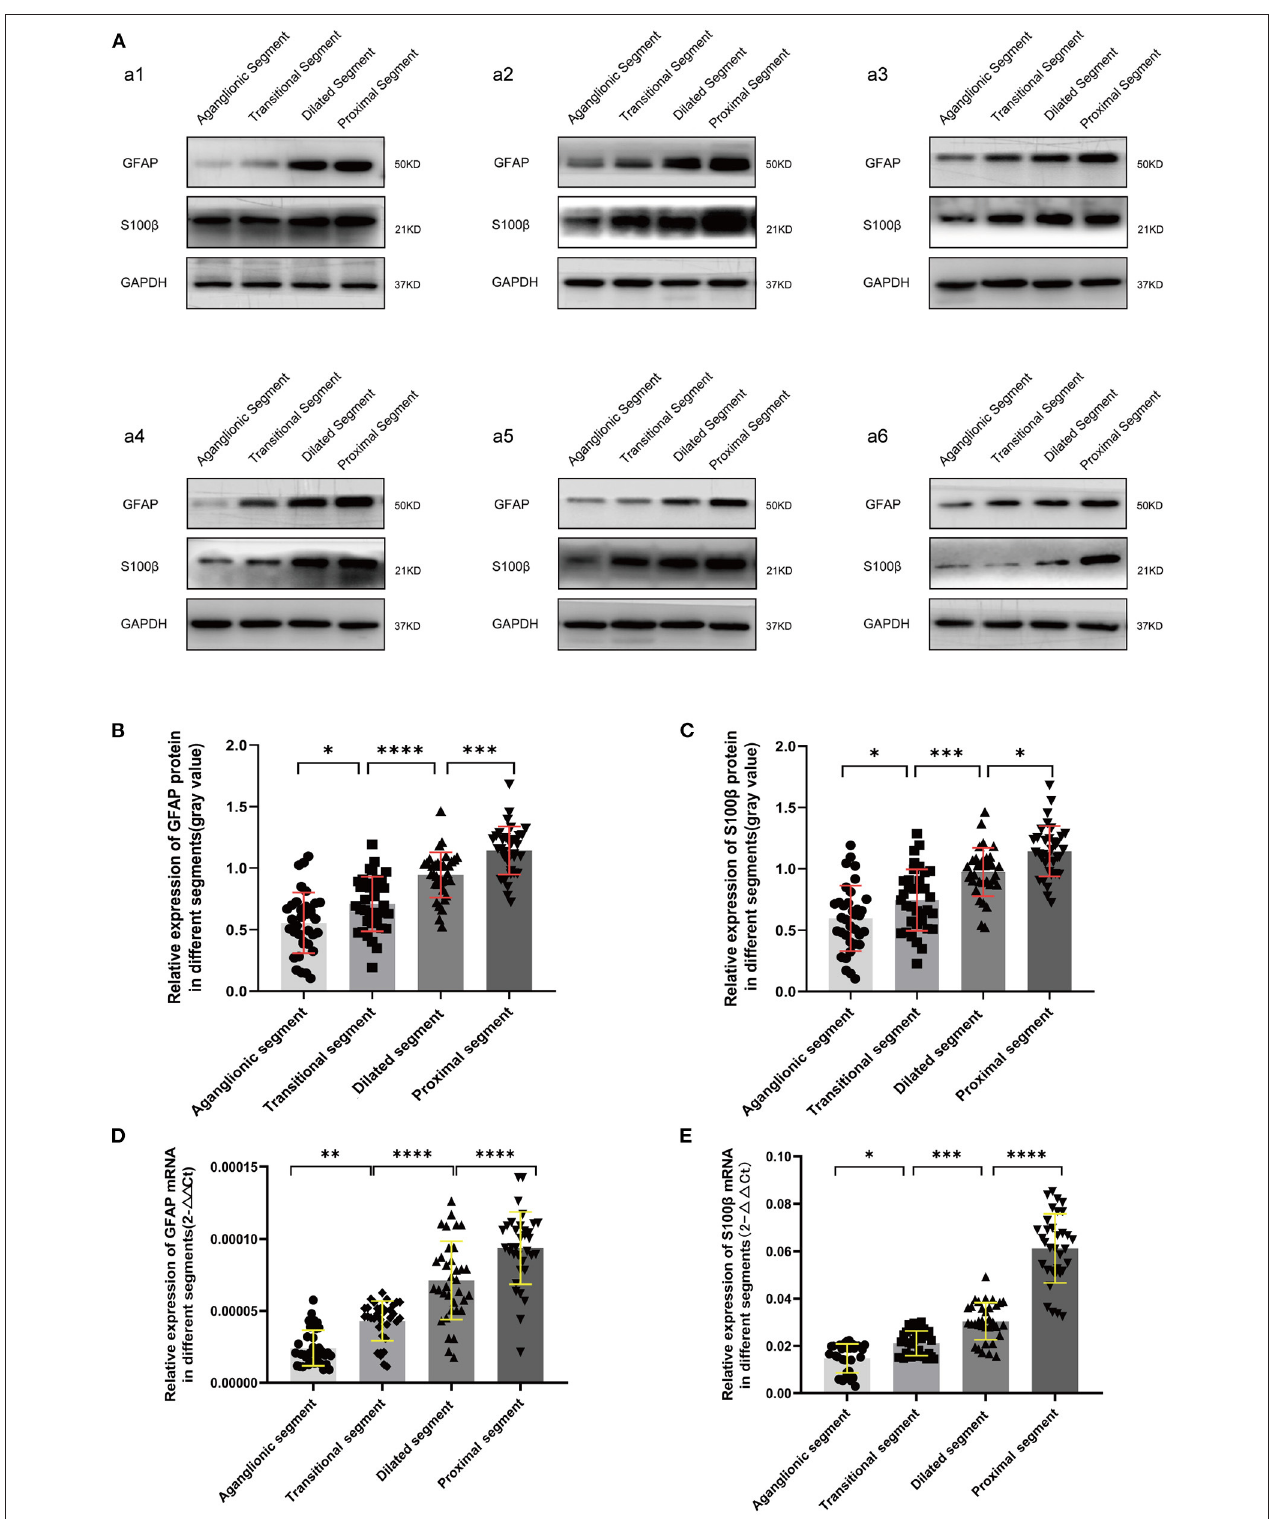
FIGURE 1 | WB (A-C) and RT-qPCR (D,E) revealed significantly decreased protein and mRNA expression of GFAP and S100 β in the diseased segments, compared with proximal segments of HSCR patients. Equal loading amounts were confirmed using glyceraldehyde 3-phosphate dehydrogenase. The assays were performed in triplicates, and values are given as mean ± SD. (ns, p > 0.05; * p < 0.05; ** p < 0.01; *** p < 0.001; **** p < 0.0001).